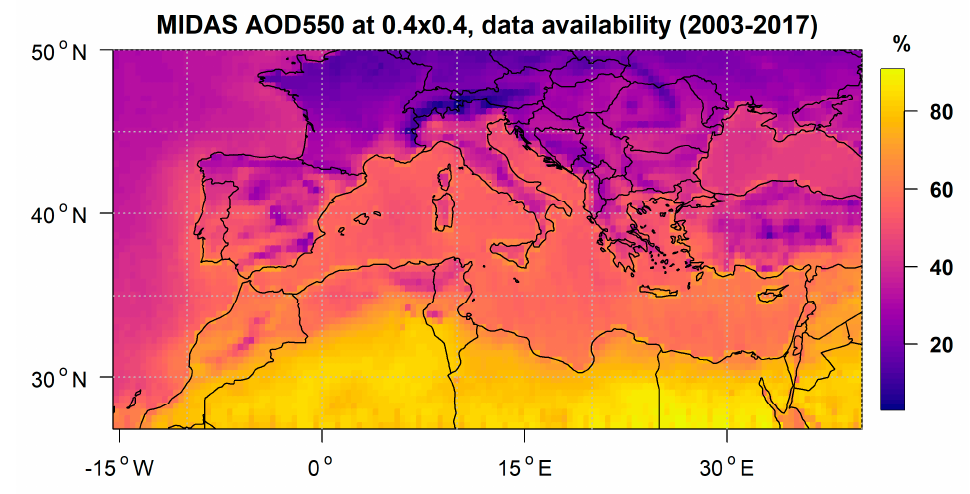
Figure 3. MIDAS dataset data availability.